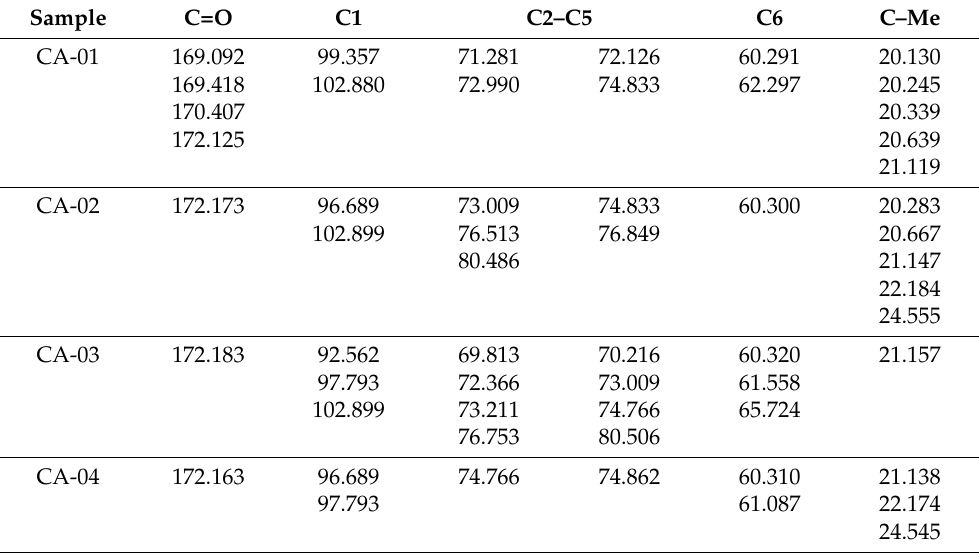
Table 4. Solid-state 13 C chemical shifts of the acetylated samples.